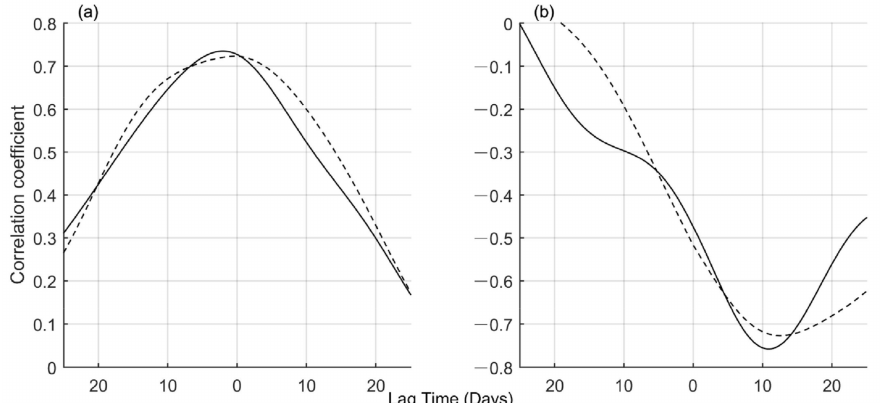
Figure 10. ( a ) Lag correlation between the depth-averaged HKEs and meridional velocities. ( b ) Lag correlation between the depth-averaged HKEs and Kuroshio intensity. The solid lines represent the total HKE, and the dashed lines represent the HKE